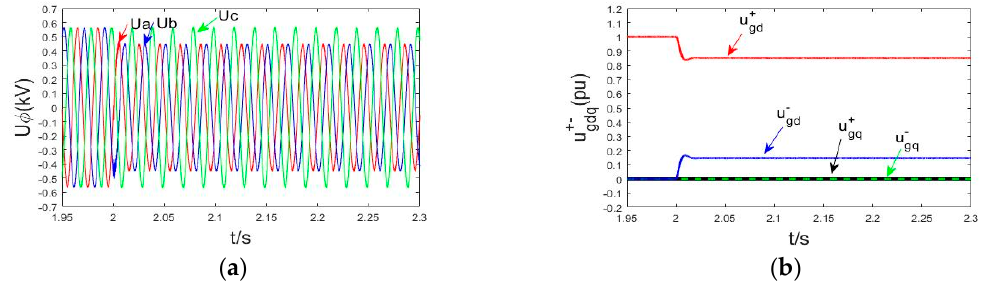
Figure 14. ( a ) Waveform of three-phase voltage. ( b ) Waveform of positive, negative sequence d , q -axis voltage.